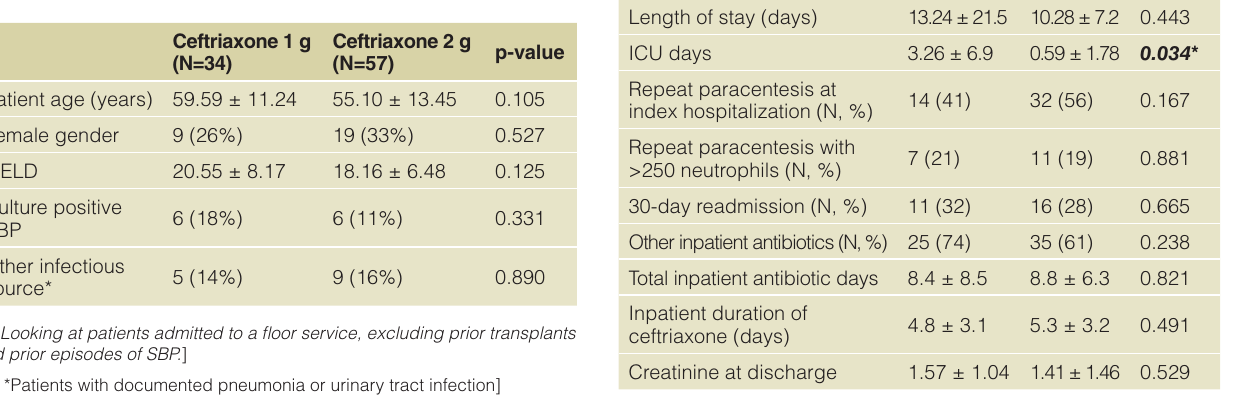
Table 1. Patient characteristics for 1 g versus 2 g ceftriaxone dose, given as N (%) for categorical variables or mean ± SD for continuous variables.